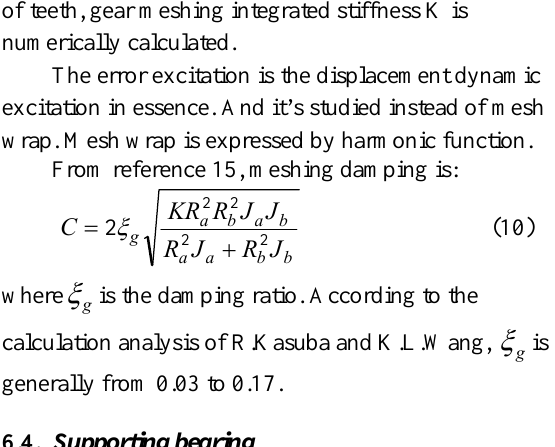
Fig.8. Modified dynamic model of gear set